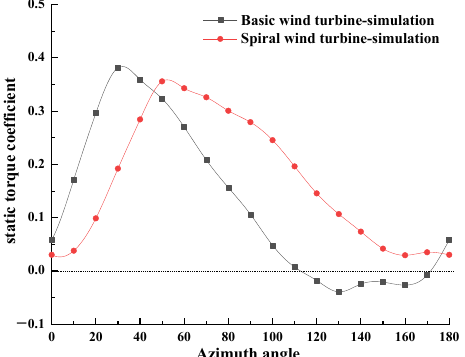
Figure 8. Static torque coefficient of basic and spiral wind turbines.